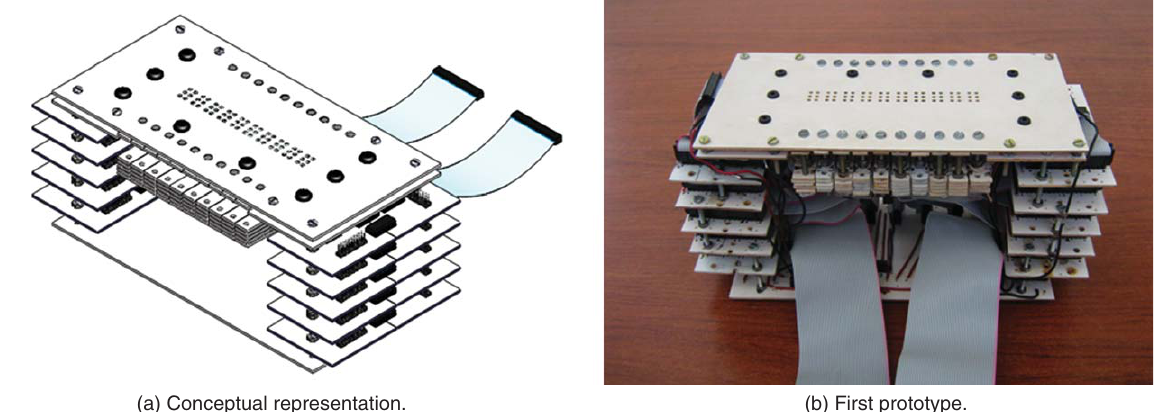
Fig. 13. The TactoBook’s first prototype of portable Braille terminal.